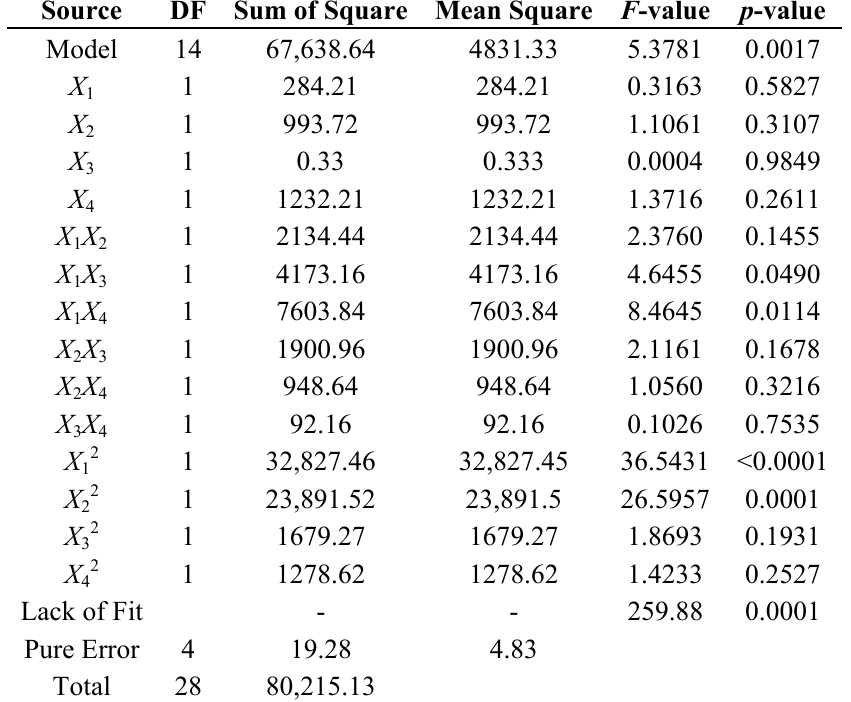
Table 2. The regression coefficients and ANOVA